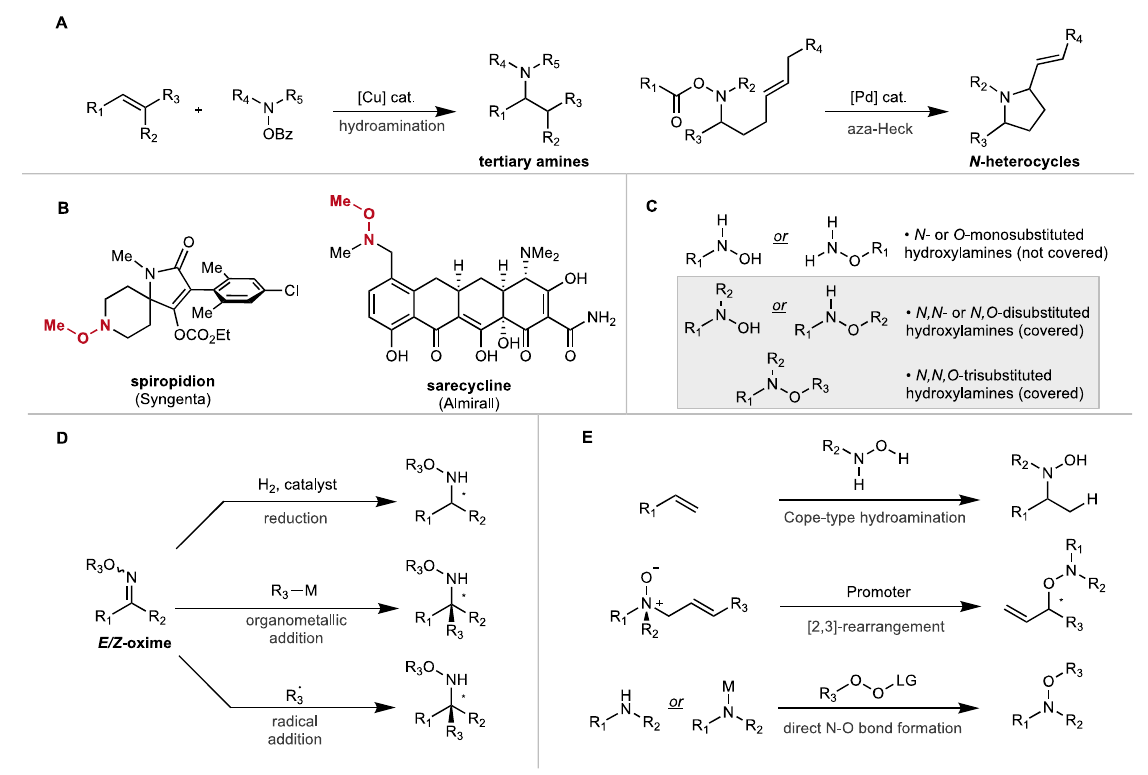
Figure 1. ( A ) Examples of the use of O -acyl- N , N -disubstituted hydroxylamines in synthesis. ( B ) The O -methoxy- N , N -disubstituted hydroxylamine moiety in approved agrochemical and pharmaceutical drug structures. ( C ) Hydroxylamine terminology and scope of the present review. ( D ) Examples of oxime transformations toward disubstituted hydroxylamines. ( E ) Select examples of hydroxyla- mine synthesis covered in this review.